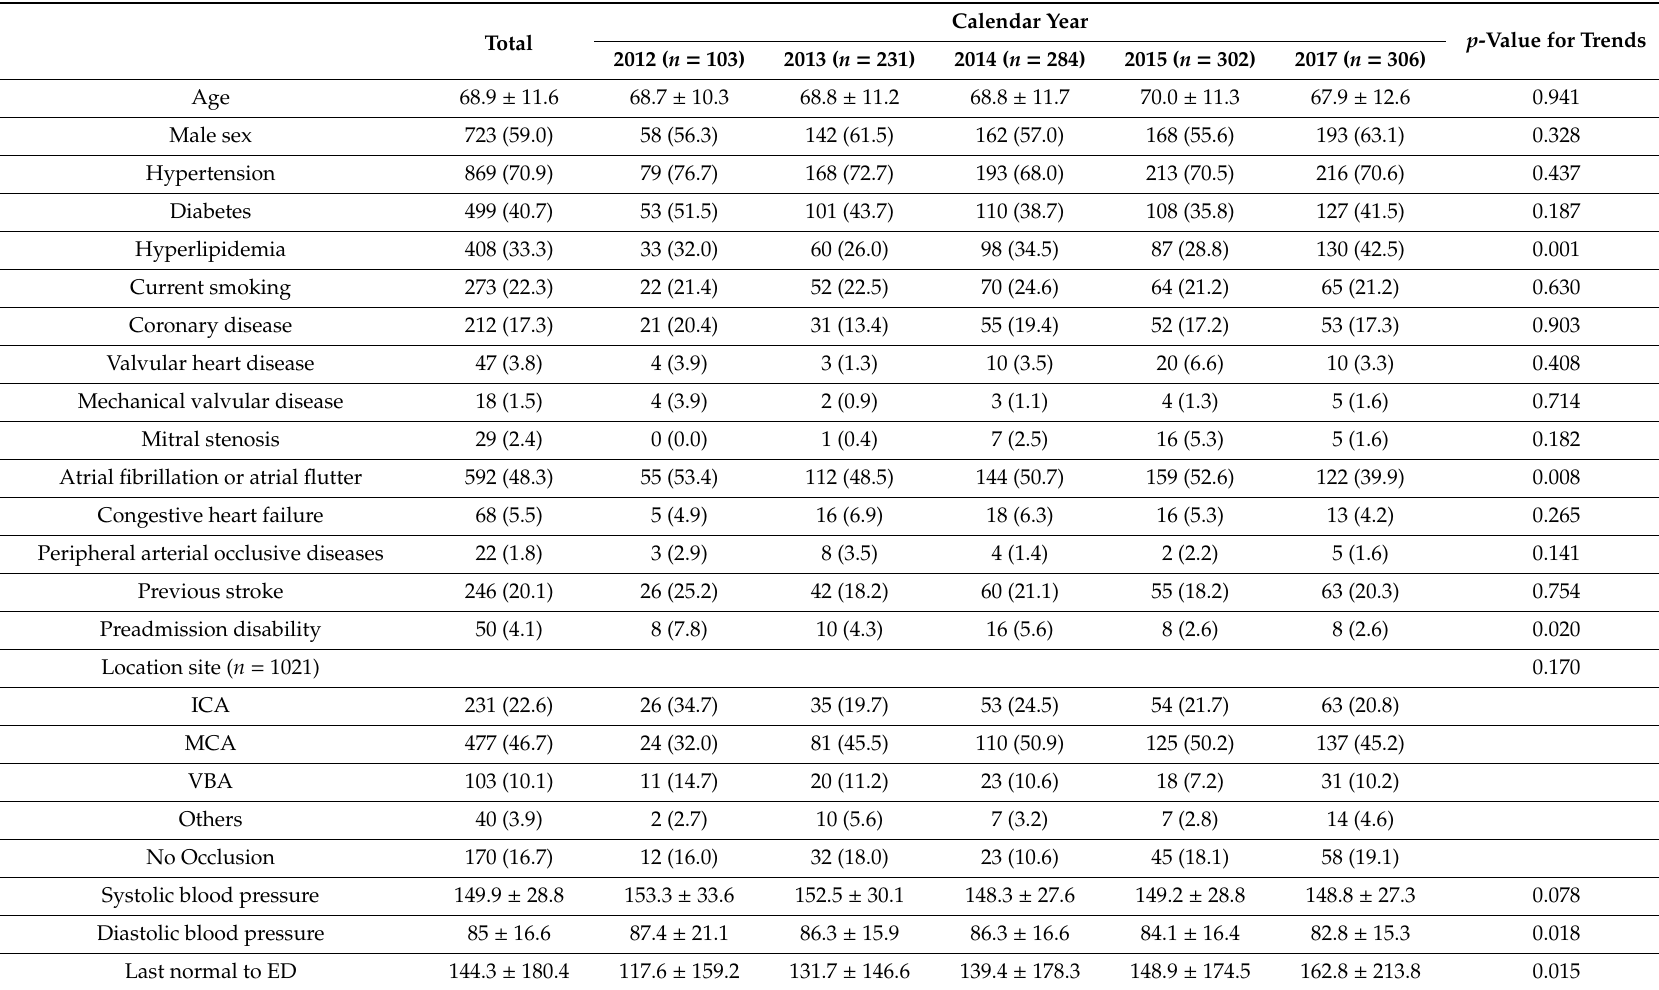
Table 1. Baseline characteristics of the included patients by